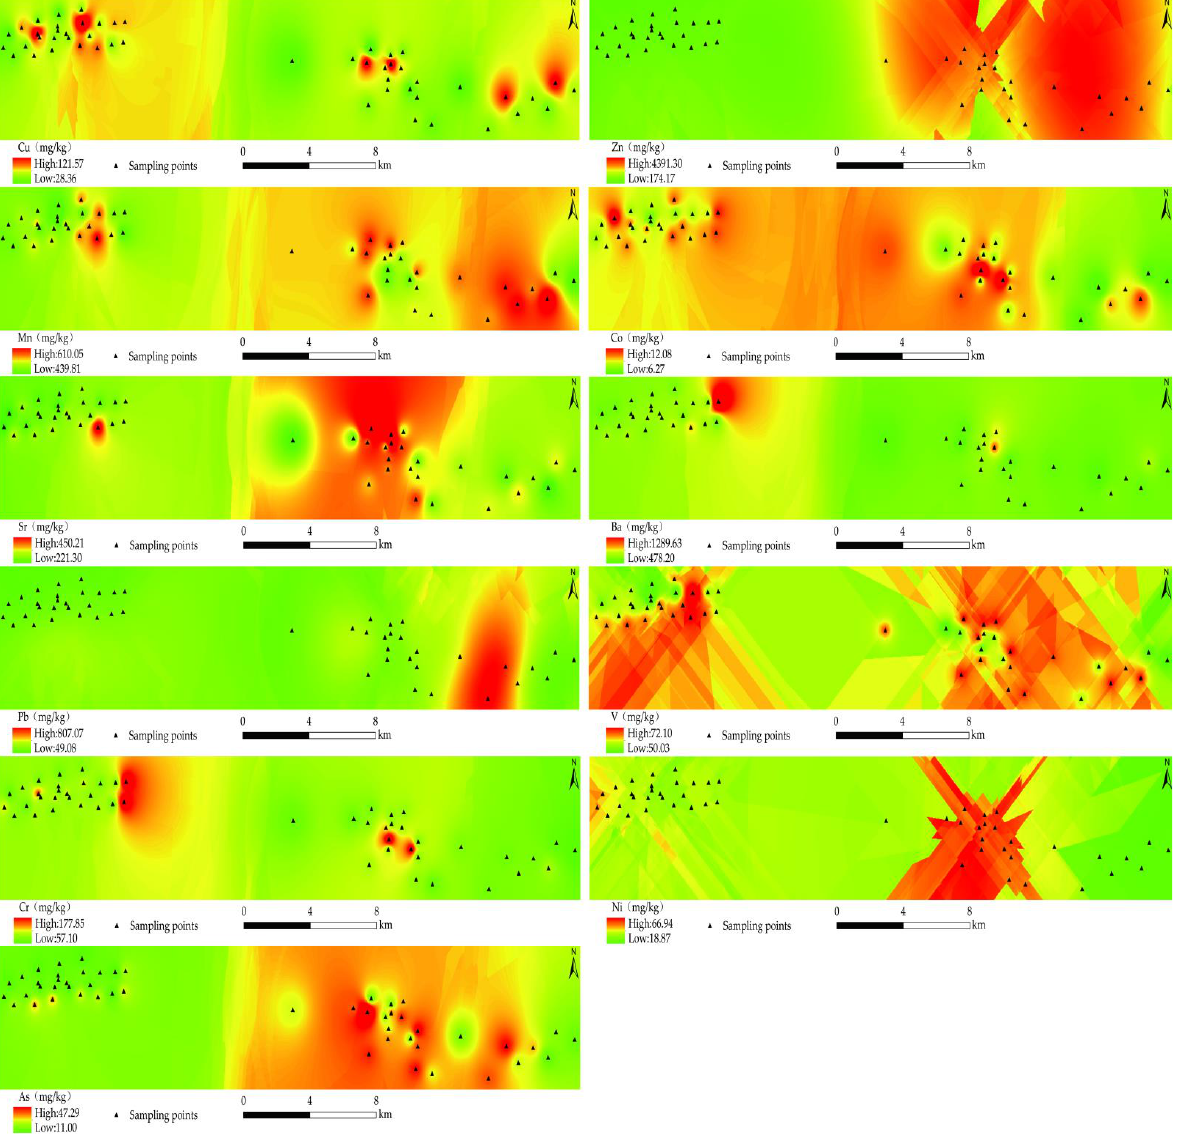
Figure 2. The spatial distribution of the concentrations of heavy metals.